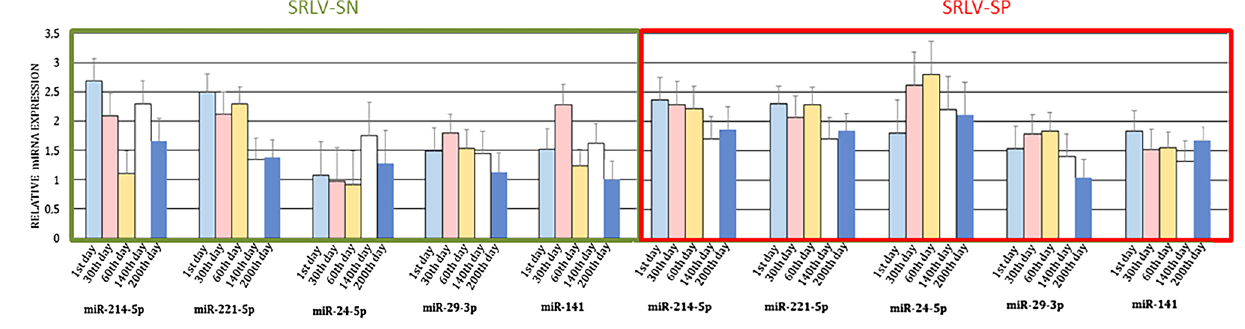
Figure 3. LSMEANS (± SE) of the five miRNA levels in milk somatic cells of SRLV-seronegative and SRLV- seropositive goats during lactation. Stages of lactation: just after kidding, on days 30th (early lactation), 60th (peak of lactation), 140th (mid-lactation), and 200th (late lactation) of lactation.